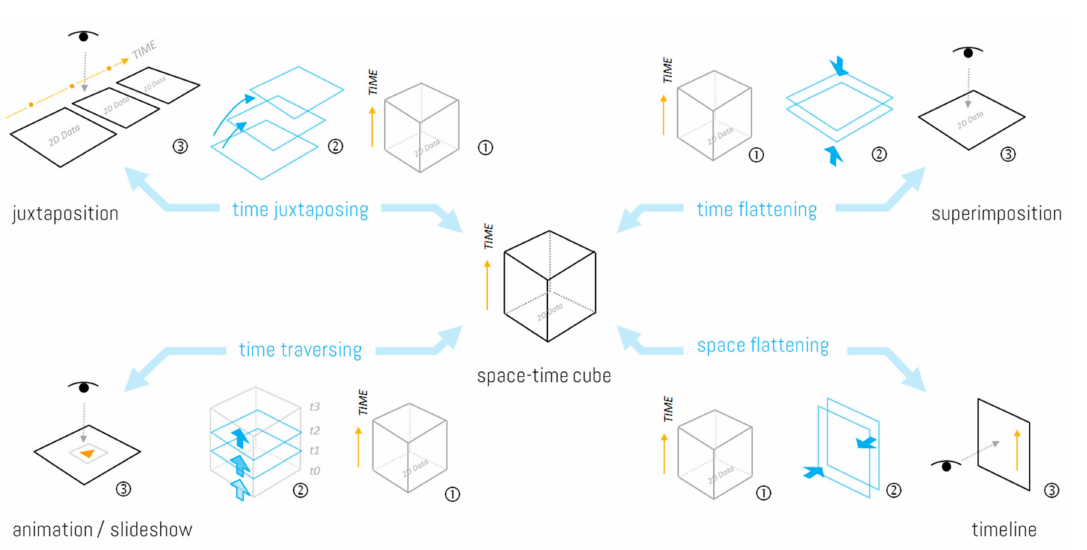
Figure 7. Space–time cube operations (in blue), seamlessly translating a space–time cube representation into four other perspectives [49,57] relevant for narrative